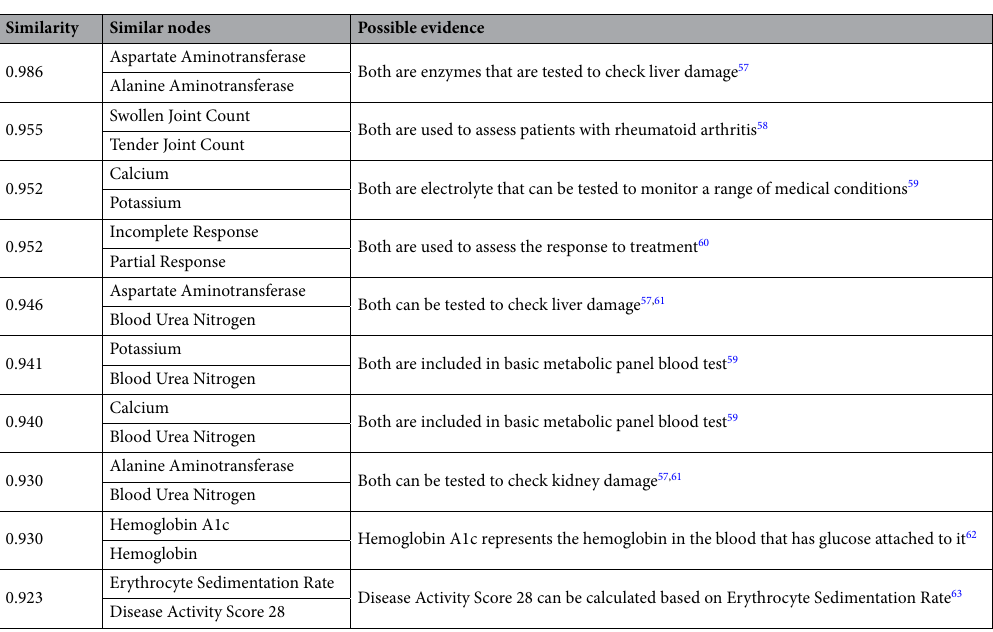
Table 8. Top-10 most similar standard-outcome nodes. The average cosine similarity among standard-outcome nodes is 0.315.